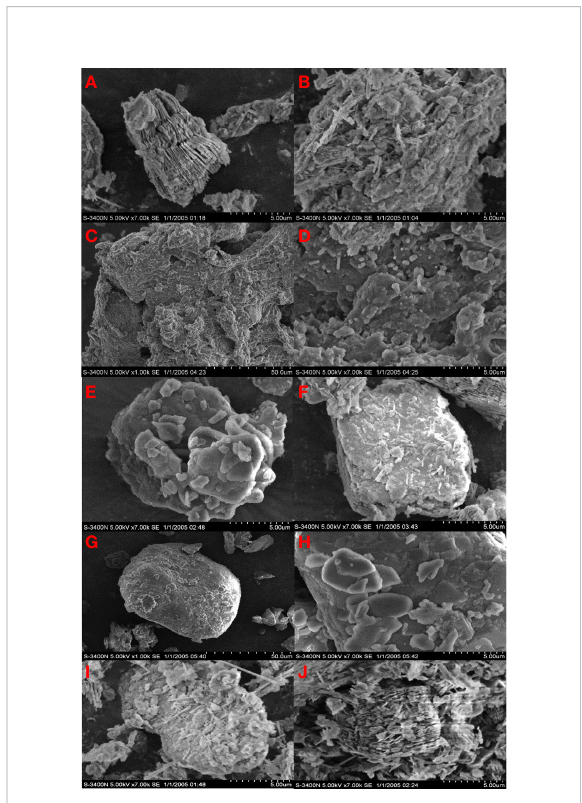
FIGURE 8 Surface structure of kaolin, modi fi ed reagents, MP and MH under SEM (A – J) .